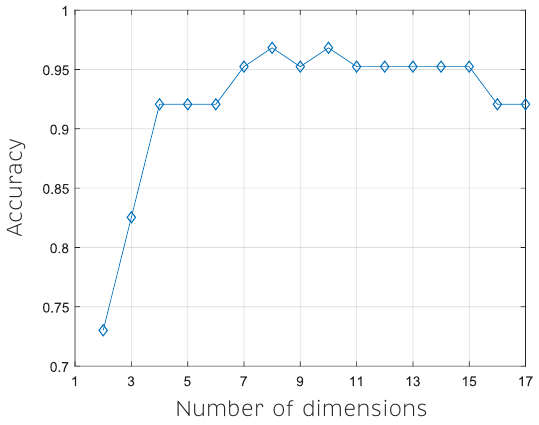
Figure 10. Variation of the number of target dimensions obtained by the t -SNE algorithm as input of the k NN classification model.